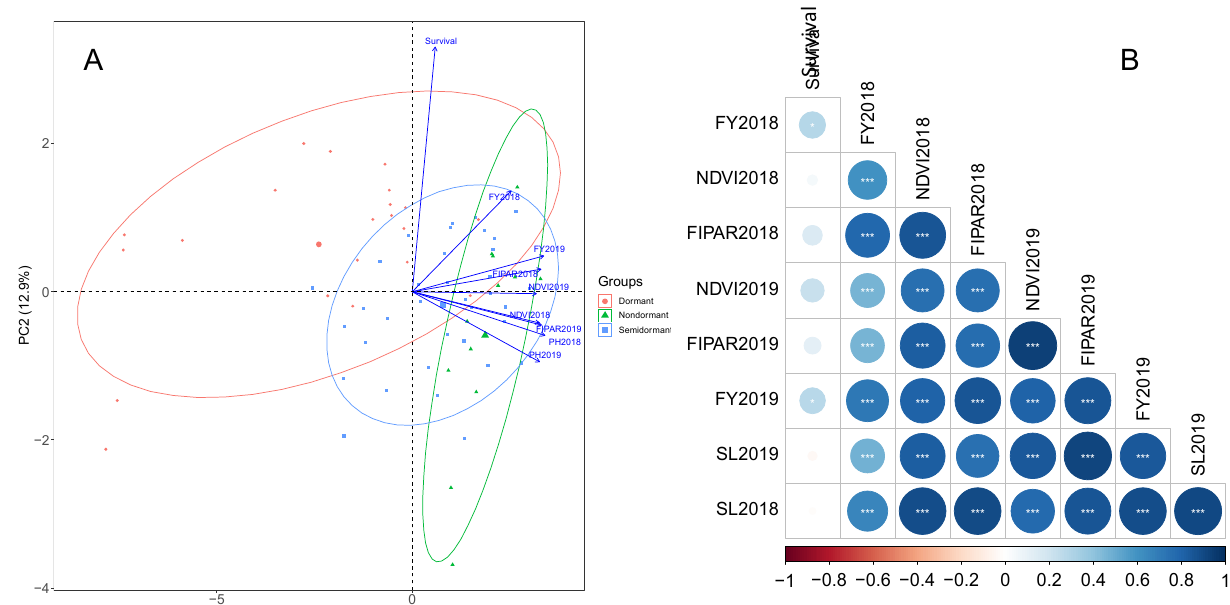
Figure 1. Biplot ( A ) and correlogram ( B ) of the first two principal components (PC1 and PC2) for the principal component analysis of nine traits evaluated in the alfalfa diversity panel in Chile. The traits are forage yield (FY), in the first (FY2018) and second (FY2019) growing seasons, plant survival (Survival), Normalized Difference Vegetation Index (NDVI), fraction of intercepted photosynthetic active radiation (FIPAR), and plant height (PH) evaluated in 2018 and 2019 growing seasons. In the correlogram * and *** refer to p < 0.05 and p < 0.001, respectively.